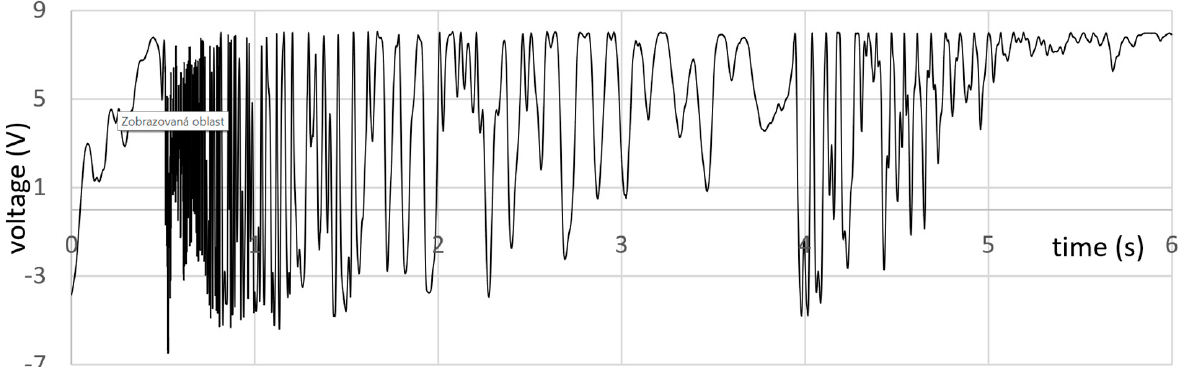
Figure 14. Detonation measurement for 15 kg of TNT at a distance of 100 m from the sensing PM fiber (4 m, single-fiber-type, transverse placement, tensioned, and a supply cable of 300 m in length). Graph of the dependence of the output voltage on time showing the effect of the surge wave (a measurement of M2-6-A).